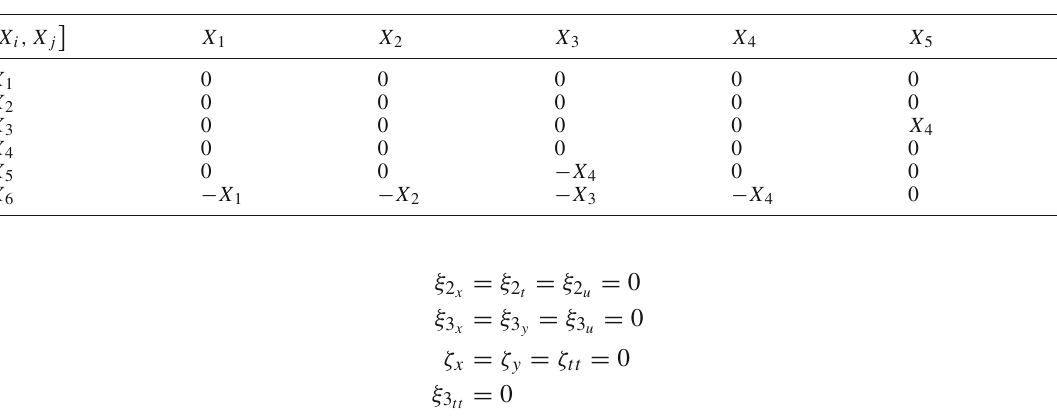
Table 1 Algebra of generators of Eq.